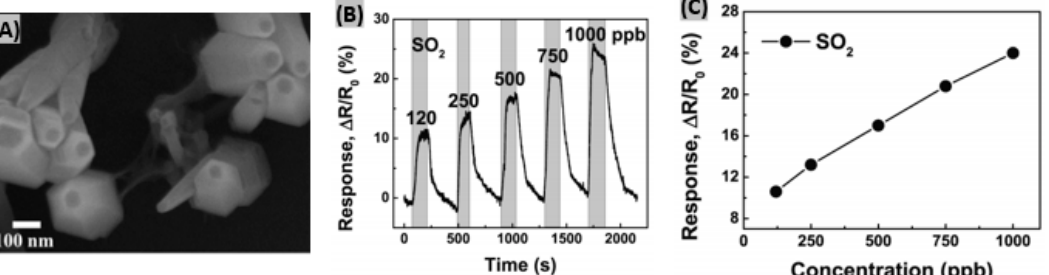
Figure 9. ( A ) Top-view of FE-SEM high magnification image of the RGO nanosheets connecting to ZnO NRs on AlGaN/GaN heterostructure. ( B ) Sensor resistance variations at the exposure to SO 2 gas of different concentrations. ( C ) Response vs. gas concentration relationship under SO 2 gas exposure.